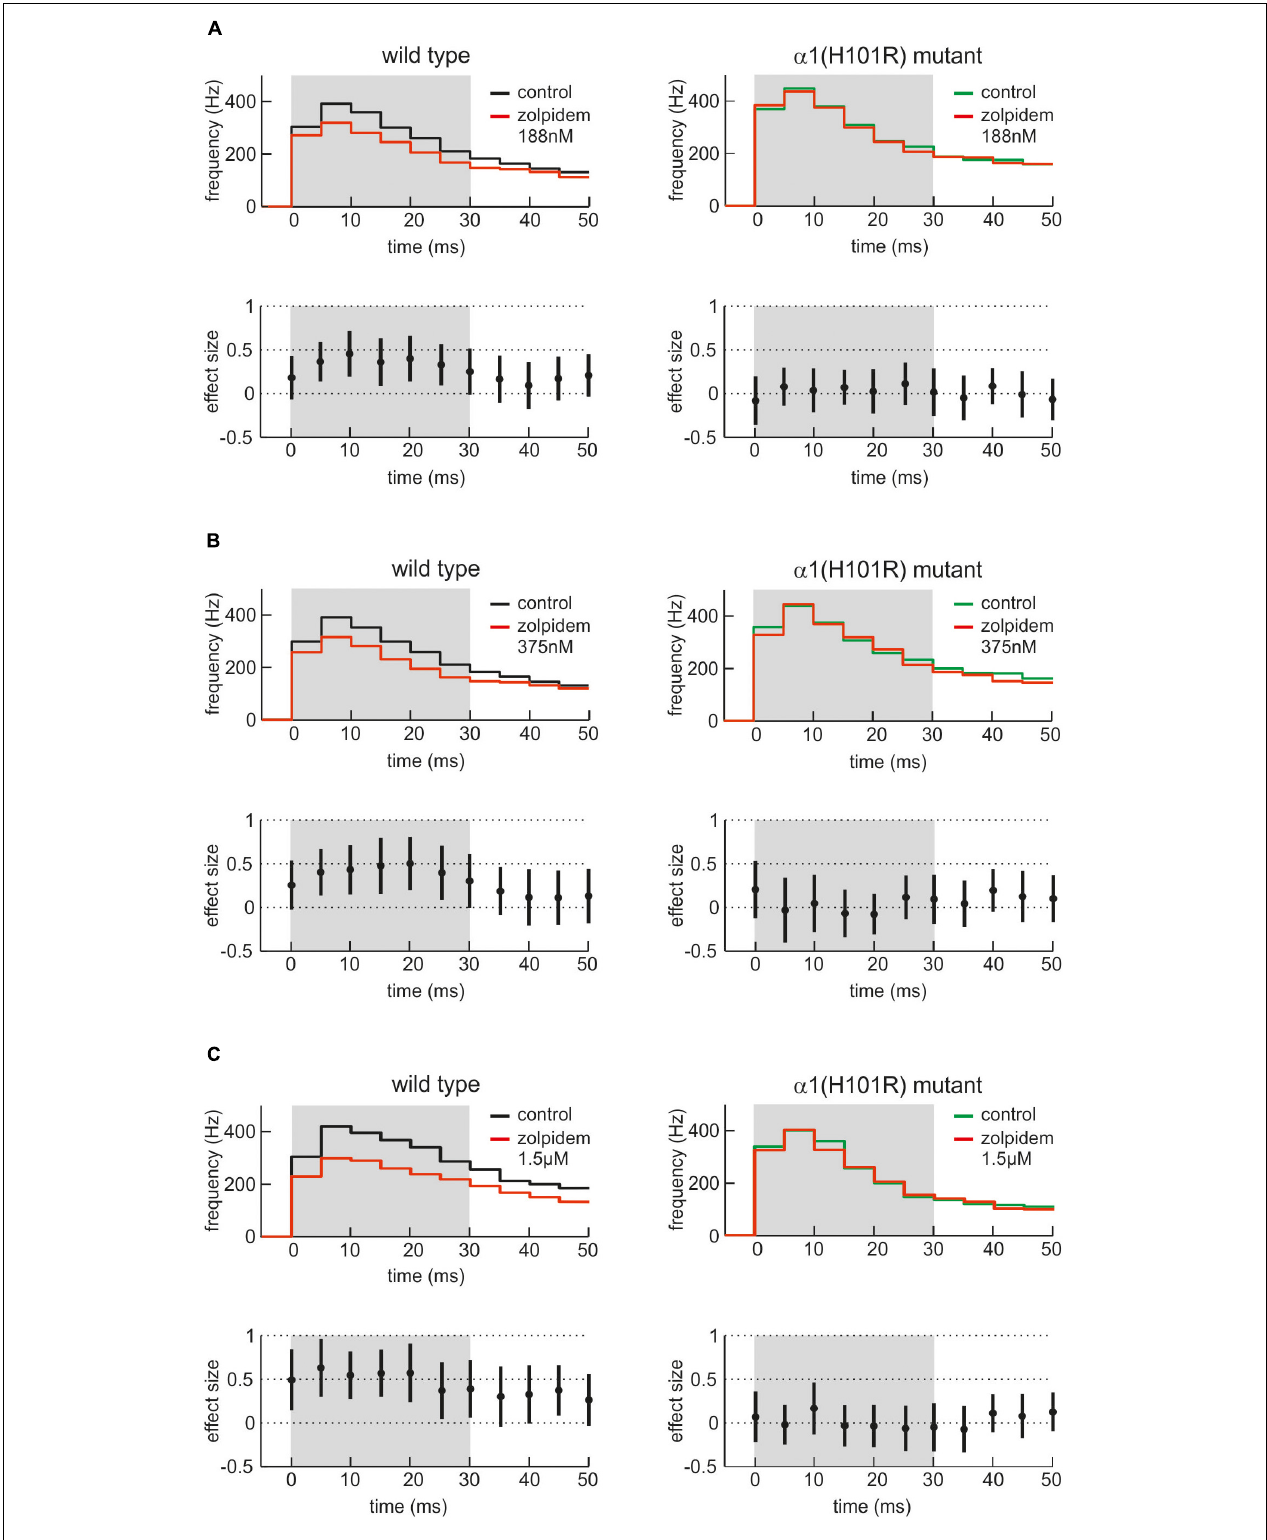
FIGURE 6 | Actions of zolpidem on phases of high neuronal activity. (A–C) The effects of three low concentrations of zolpidem ( A : 188 nM; B : 375 nM; C : 1.5 µ M, n = 29 – 41, presence of zolpidem indicated in red) are given as PETH with corresponding effect sizes for wild type cultured cortical neurons (left side, black)